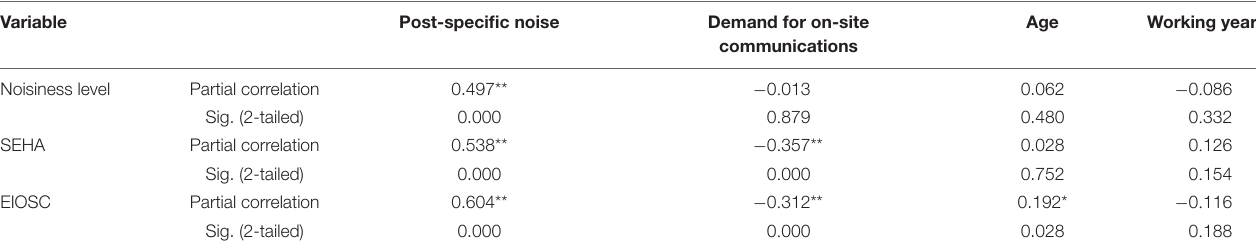
TABLE 5 | Results of partial correlation in evaluation results and related